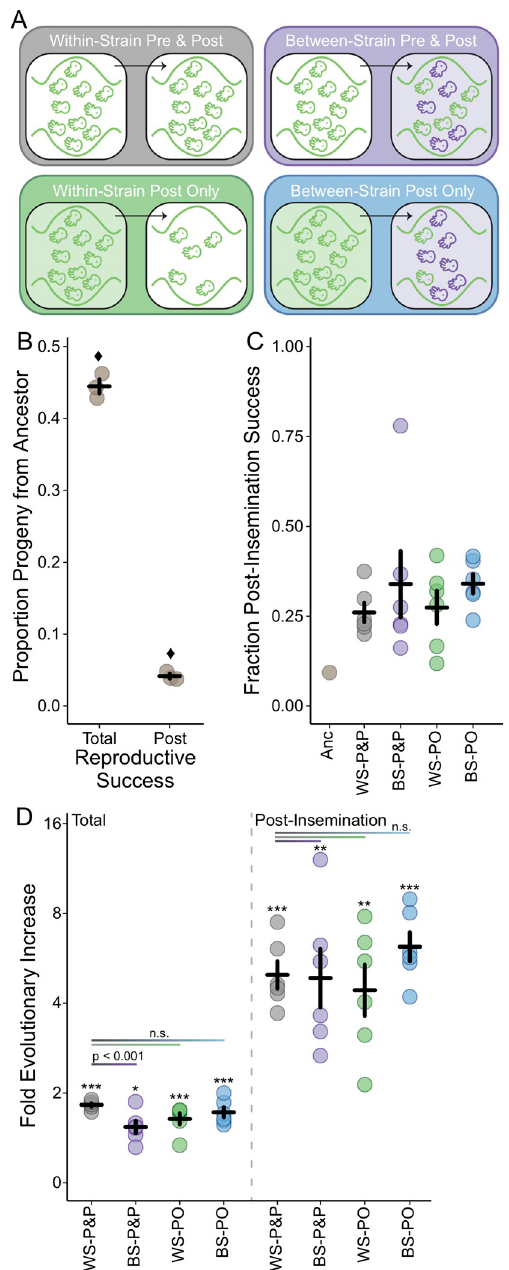
Fig 2. The competitive reproductive success of males before and after experimental evolution under four sexual selection regimes. A) Partitioning the sterility and competition treatments leads to four experimental evolution regimes: within-strain pre- and post-insemination competition (WS-P&P, gray), within-strain post-insemination only competition (WS-PO, green), between-strain pre- and post-insemination competition (BS-P&P, purple), and between- strain post-insemination only competition (BS-PO, blue). B) Ancestral males have poorer reproductive success than competitor males under both pre- and post-insemination competitive conditions (total) and under only post- insemination competitive conditions. Each point represents an independent assay with the mean and standard error across assays given. Diamonds denote a significant deviation from the null hypothesis of equal competitive ability between ancestral and competitive males for each condition (total: χ 2 = 6.87, d.f. = 1, p < 0.01, 95% C.I. of ancestral competitive success = 40.4–48.6%; post-insemination: χ 2 = 863, d.f. = 1, p < 0.0001, 95% C.I. of ancestral sperm competitive success = 3.0–5.5%). C) The fraction of total reproductive success attributable to post-insemination success in the ancestral population (Anc) and the evolved populations (G31: WS-P&P, BS-P&P, WS-PO, BS-PO). Each point represents a mean of three independent assays for the ancestor and each evolved replicate with the mean